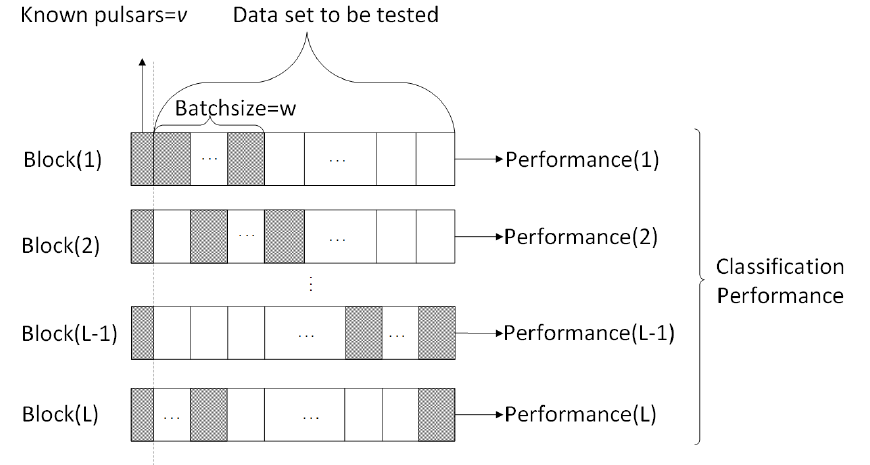
Figure 3. Data partition based on sliding